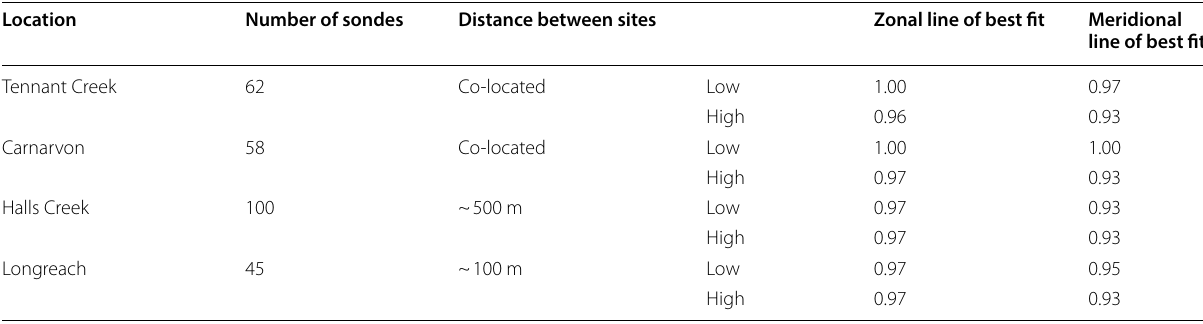
line of best fit